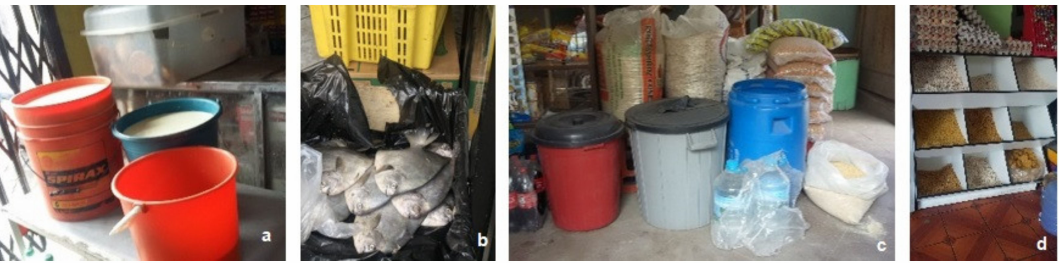
Figure 4. ( a ) Milk, ( b ) fish without refrigeration, ( c ) grains and cereals, and ( d ) pasta dispensed without adequate hygiene.